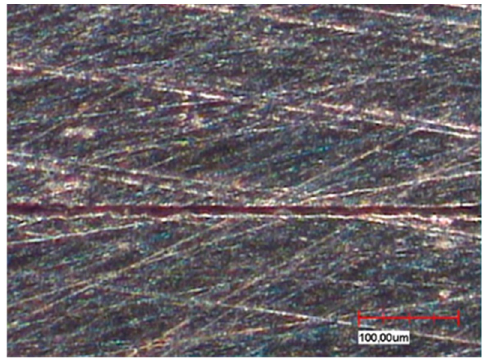
Figure 7. Cut surface of milled non-precious metal telescope (lingual, complete contact surface at parallel milling).